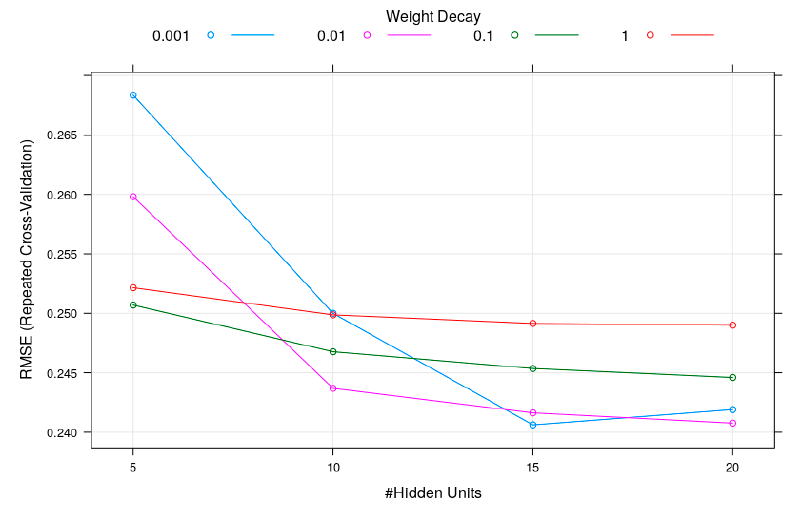
Figure 10. Hyper-parameter optimization for neural networks in repeated 10-fold cross validation.